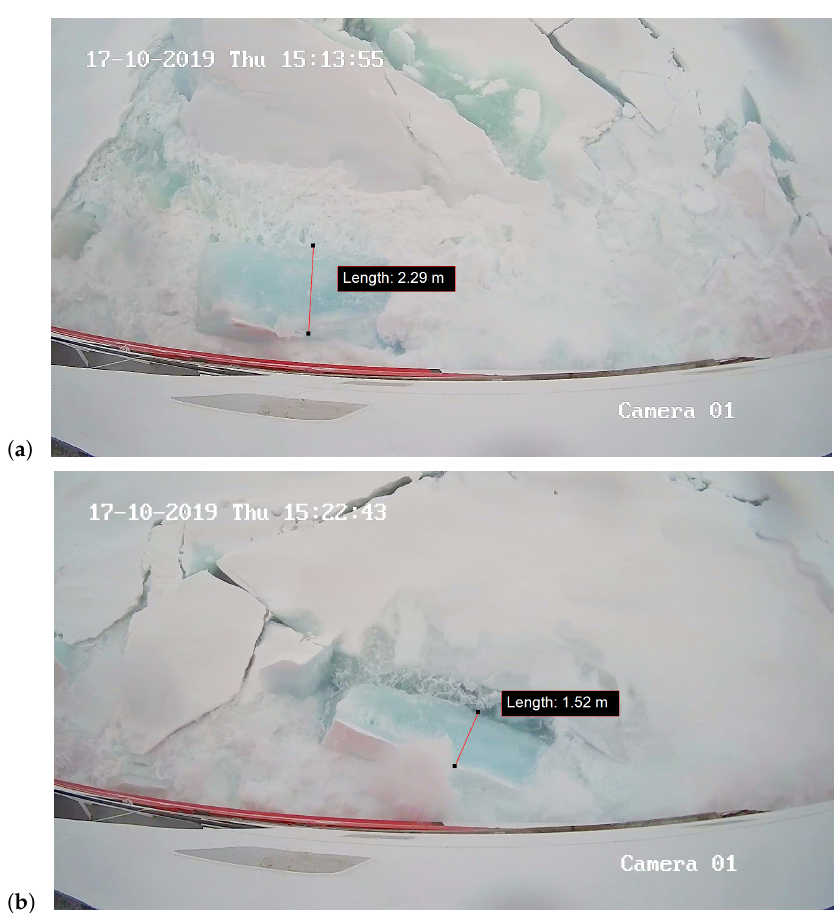
Figure 17. Ice thickness values: two frames corresponding to events 2 ( a ) and 6 ( b ) shown in Figure